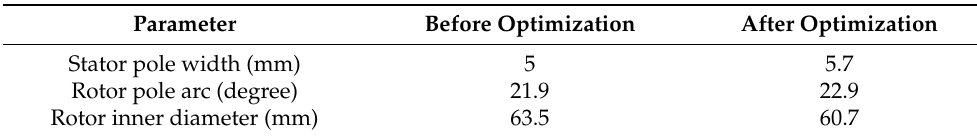
Table 3. SRM parameters before and after the